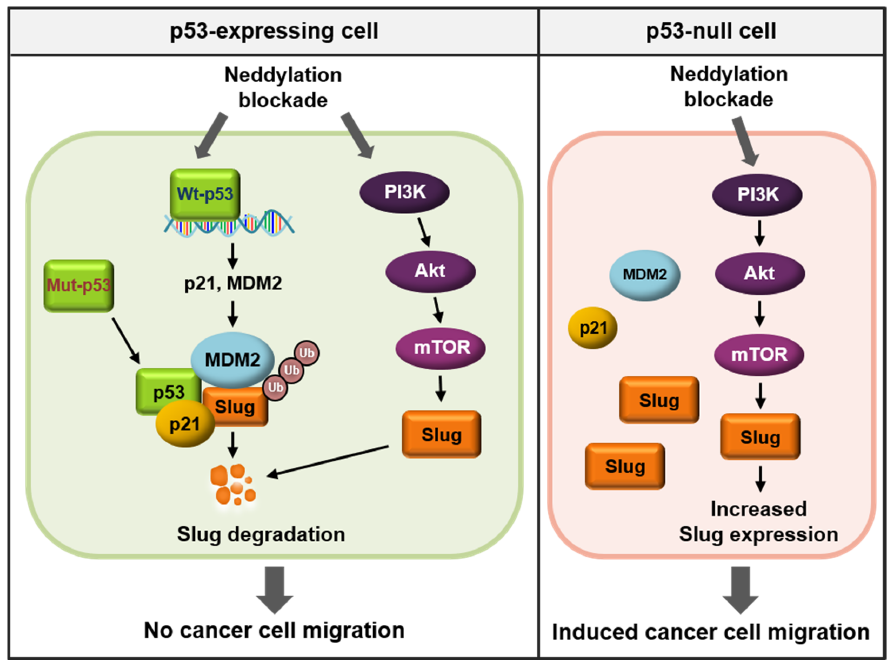
Figure 8. Schematic illustrating the different roles of neddylation blockade according to p53